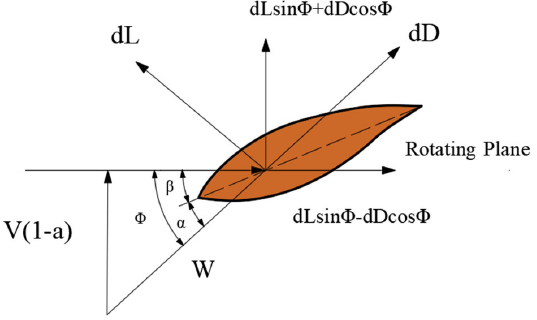
Figure 6. Velocity triangle of the blade element cross-section and forces on the airfoil.